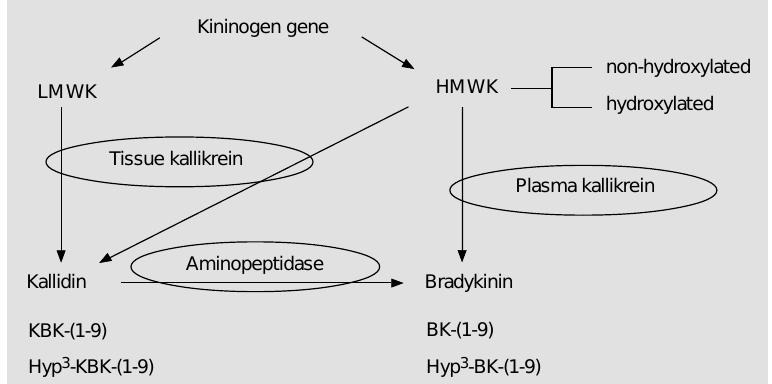
Figure 1 - Generation of kinin peptides by tissue and plasma kallikrein. In man tissue kallikrein generates kallidin whereas plasma kallikrein generates bradykinin (BK). However, in the rat both tissue and plasma kallikrein generate bradykinin. LMWK, HMWK, Low and high molecular weight kininogens, respectively; KBK, kallidin (Lys 0 -bradykinin); Hyp 3 , hy- droxylated proline.